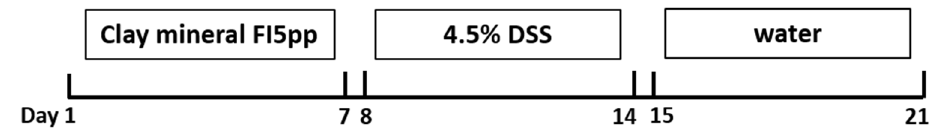
Figure 5. Animal treatment protocol for prophylactic treatment and induction of acute colitis.